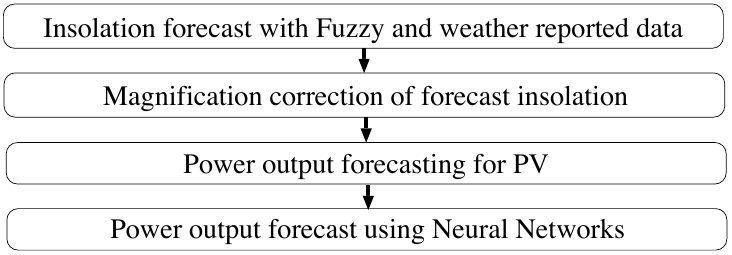
Figure 3. Forecasting